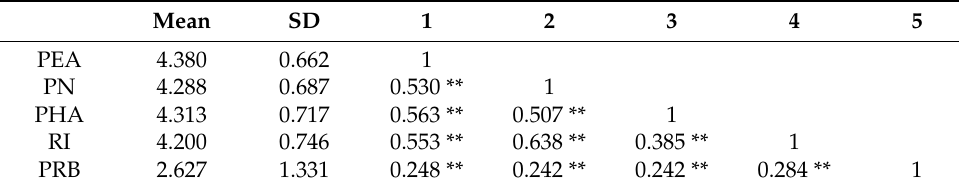
Table 2. Descriptive statistics and correlations among variables.